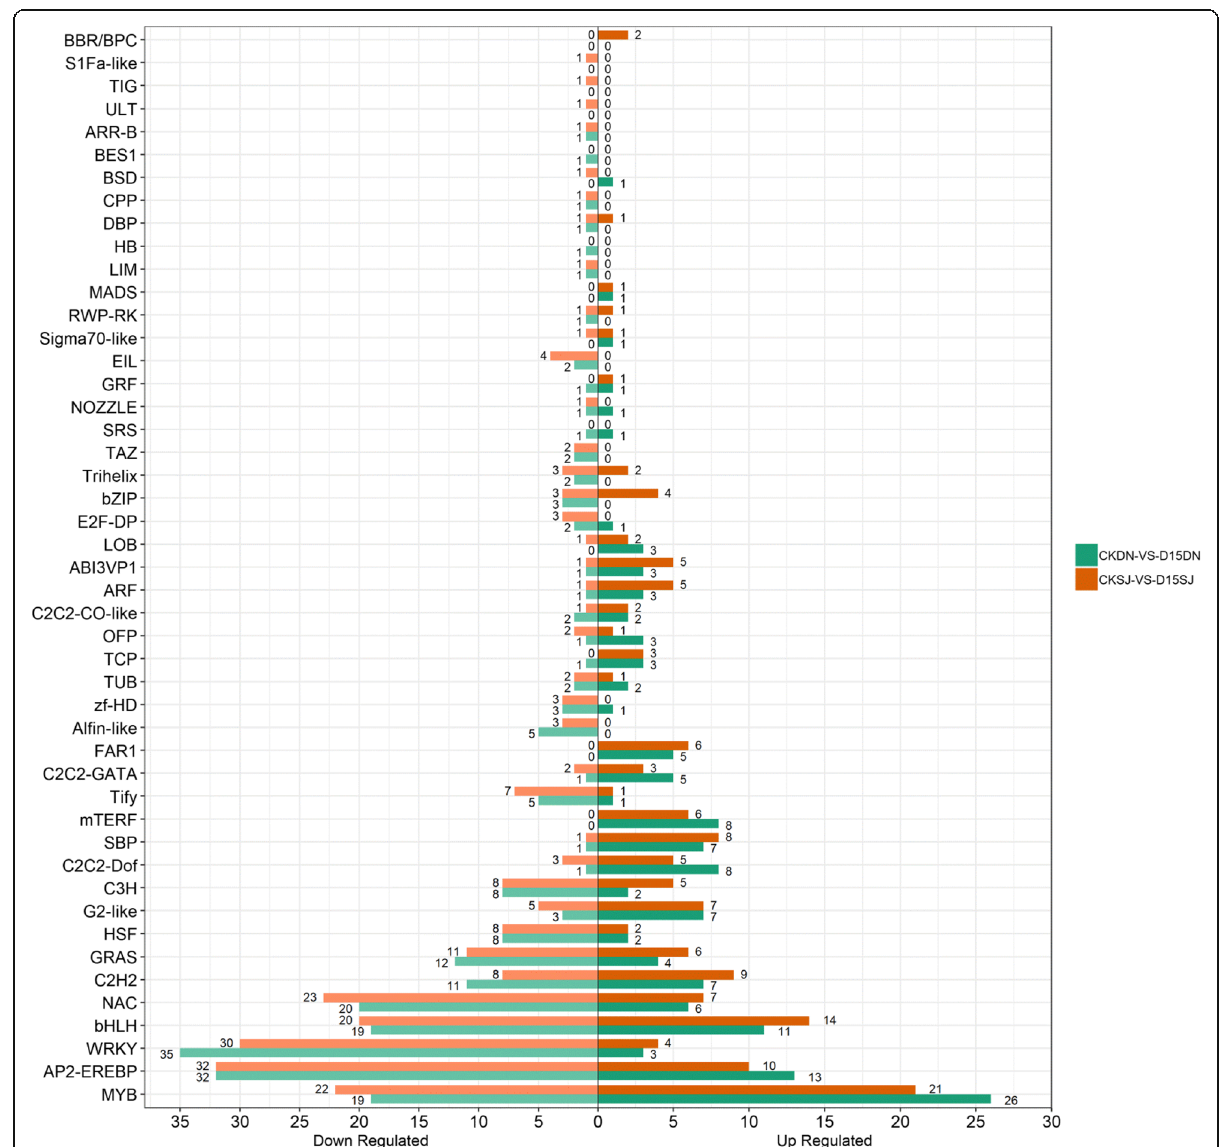
Fig. 6 Identification of the transcription factors (TFs) responding to cold